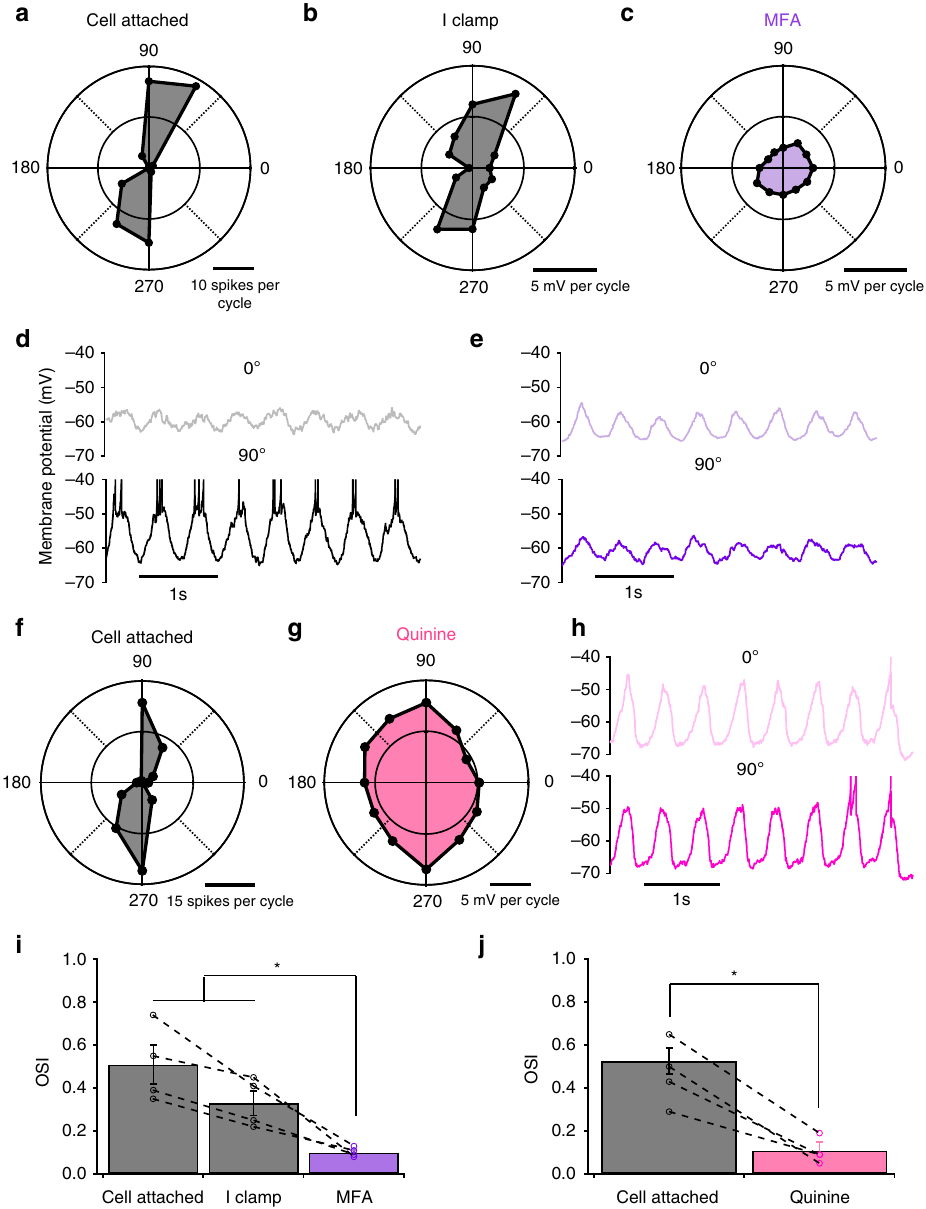
Fig. 7 Electrical synaptic inputs are necessary for OS. a Polar plot of drifting grating responses of an example OFF OS RGC. b , c Polar plot of drifting grating responses of the same cell in a in current clamp before ( b ) and after ( c ) bath application of MFA. d , e Raw traces of recorded membrane potentials of the same cell in a along preferred and null orientations before ( d ) and after ( e ) bath application of MFA. f Polar plot of drifting grating responses of an example OFF OS RGC. g Polar plot of drifting grating responses of the same cell in f in current clamp after intracellular application of quinine. h Raw traces of recorded membrane potentials of the same cell in f along preferred and null orientations after intracellular application of quinine. i OSI of drifting gratings responses in cell attached mode (grey) and in current clamp mode before (grey) and after (purple) MFA application. Error bars indicate SEM across n = 4 ( n = 2 OFF hOS and n = 2 OFF vOS) cells. Dashed lines connect measurements from the same cell. j OSI of drifting gratings responses in cell attached mode (grey) and in current clamp mode after quinine application (pink). Error bars indicate SEM across n = 4 ( n = 2 OFF hOS and n = 2 OFF vOS) cells. * p <